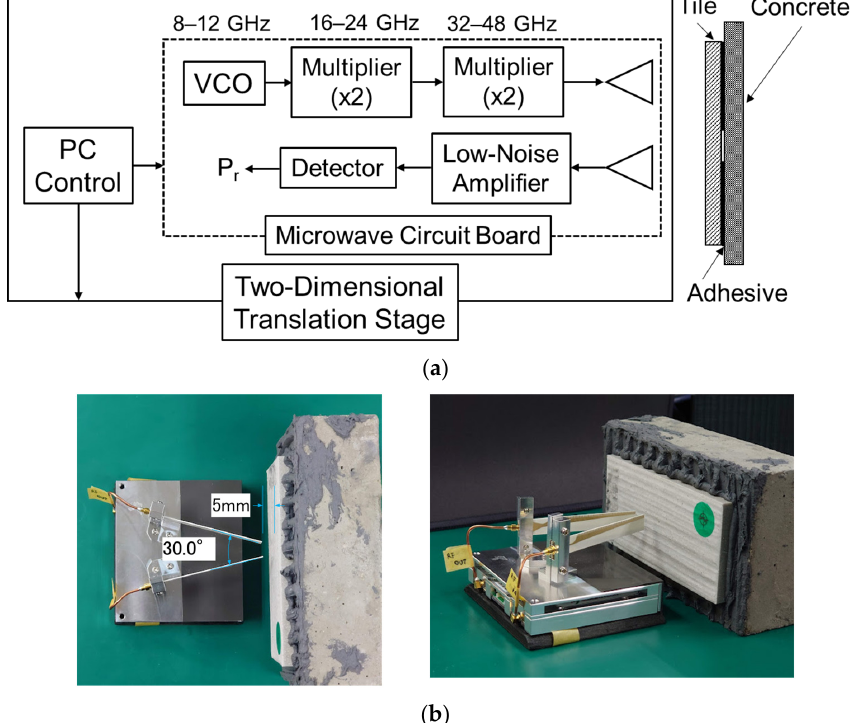
Figure 3. ( a ) Schematic of the prototype system; ( b ) picture of the transmitting and receiving antennas.